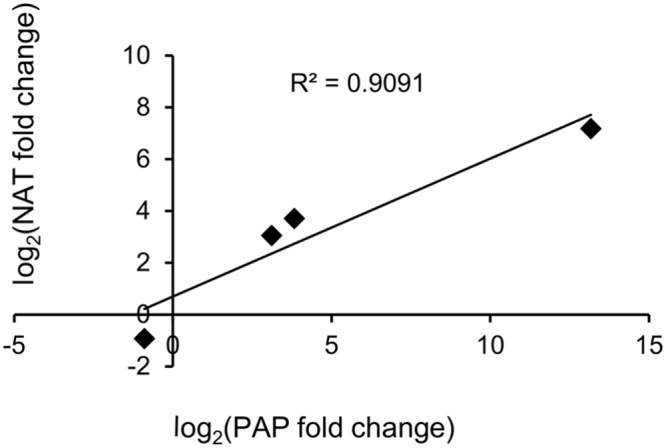
Expression of PAP sense and antisense transcripts. The correlation of JA-induced expression changes obtained by RNA-seq is shown for each PAP isoform and its corresponding NAT.